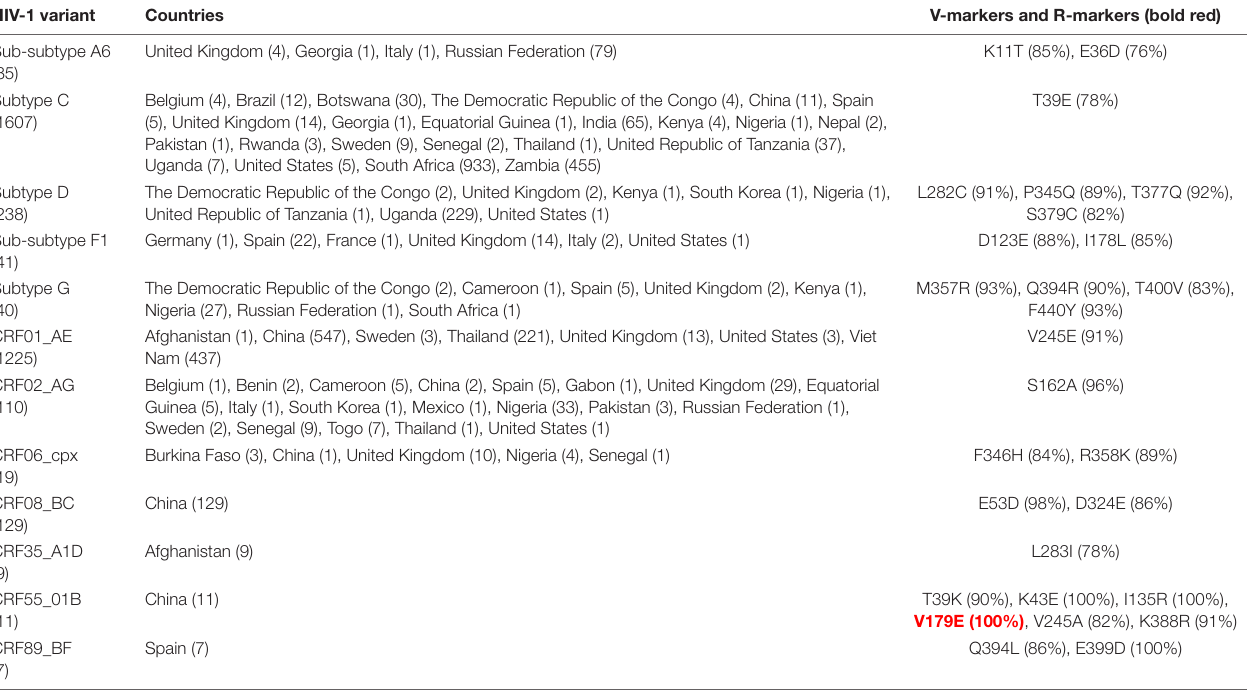
TABLE 3 | Single V-markers and R-markers in reverse transcriptase found across HIV-1 variants with > 5 LANL sequences. HIV-1 variant V-markers and R-markers (bold